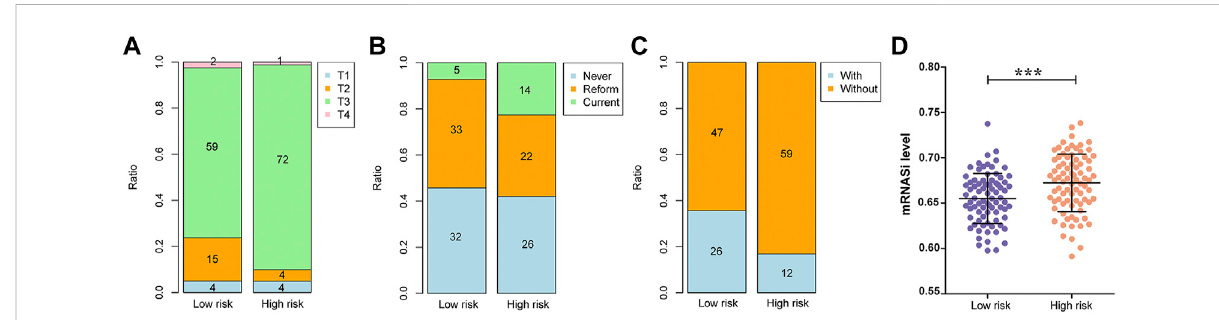
FIGURE 7 Associations between the risk score and clinical data as well as mRNAsi values. (A) The association between the risk score and pathologic T grading. (B) The association between the risk score and tobacco history. (C) The association between the risk score and radiotherapy. (D) The association between the risk score and mRNAsi values.